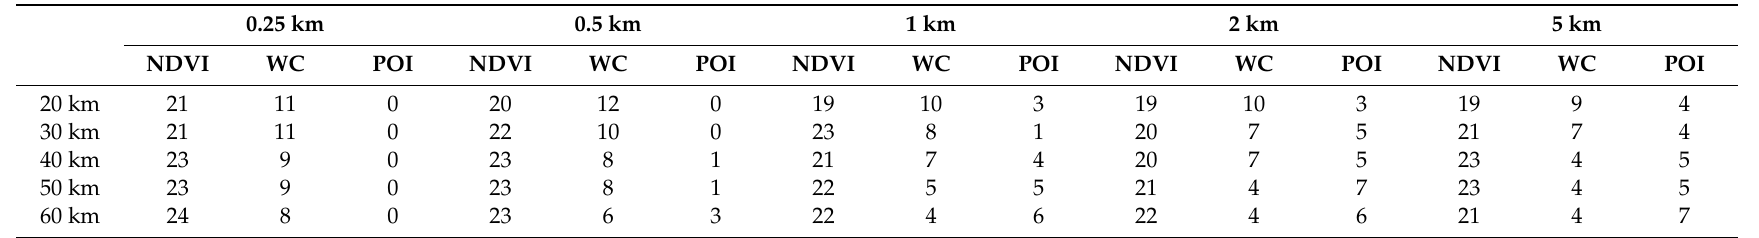
Table A2. Count of the cities for each factor that should the most importance for explaining the LST pattern under di ff erent